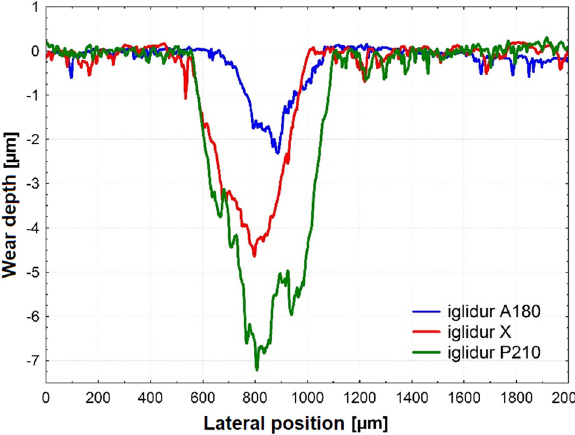
Figure 3: Representative pro fi les show the sign of wear after the ball - on - disc test.